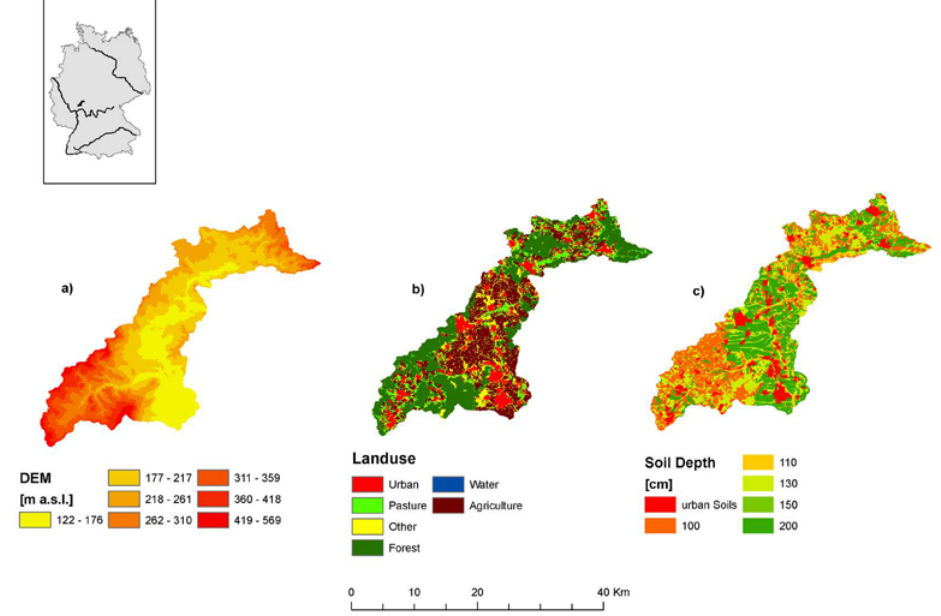
Fig. 1. Overview of the study area; with (a) elevation, (b) land use and (c) soil